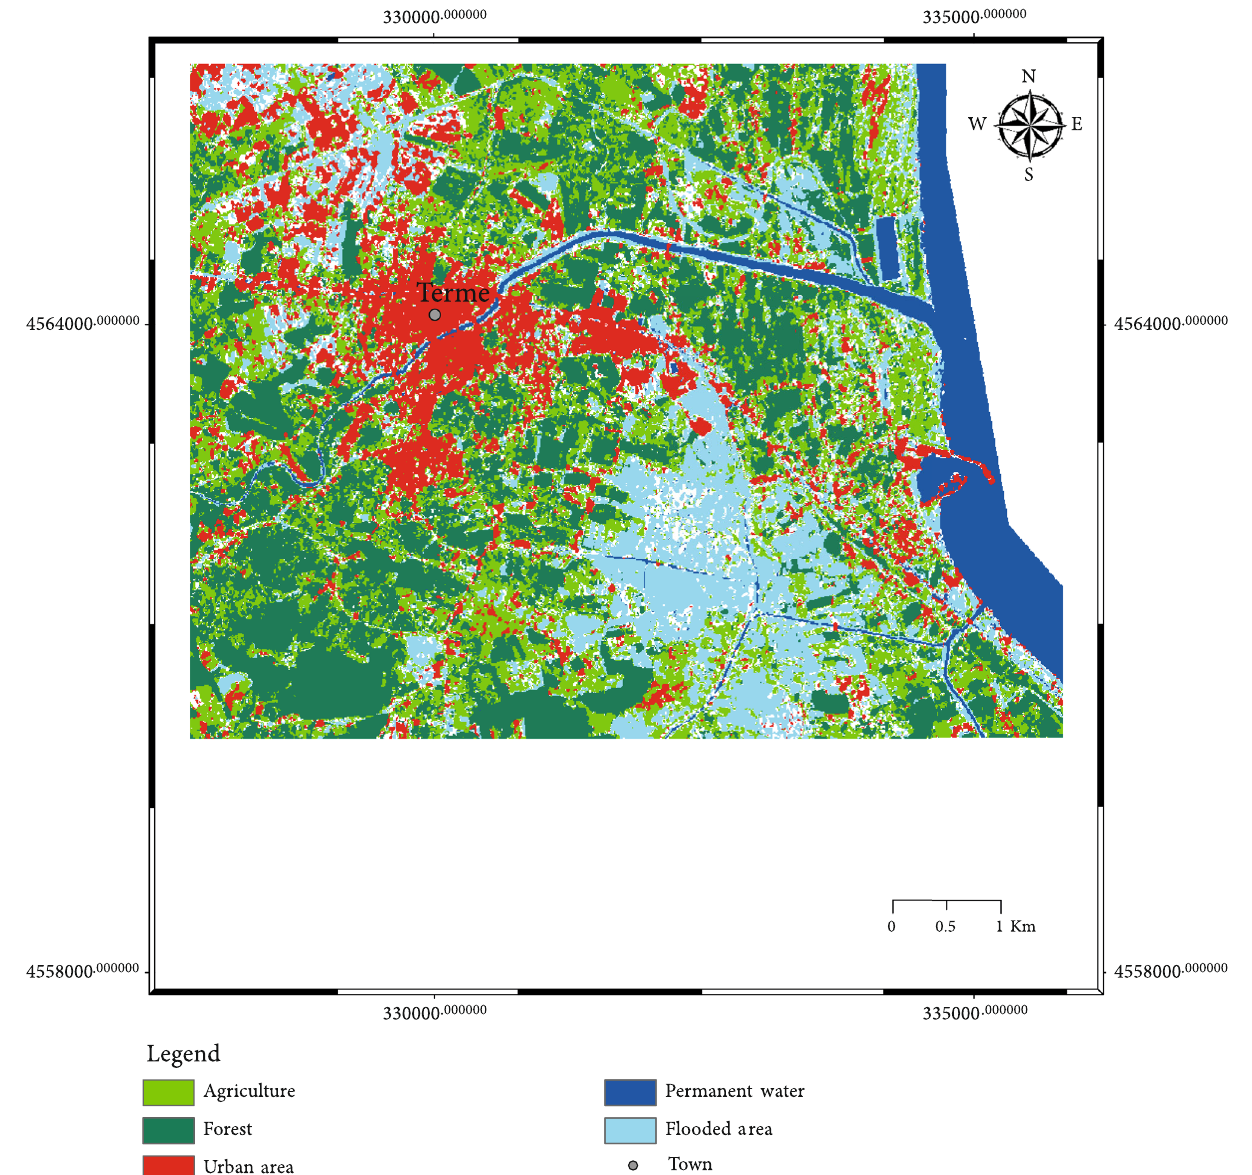
Figure 12: Result of the fl ood analysis produced for Terme